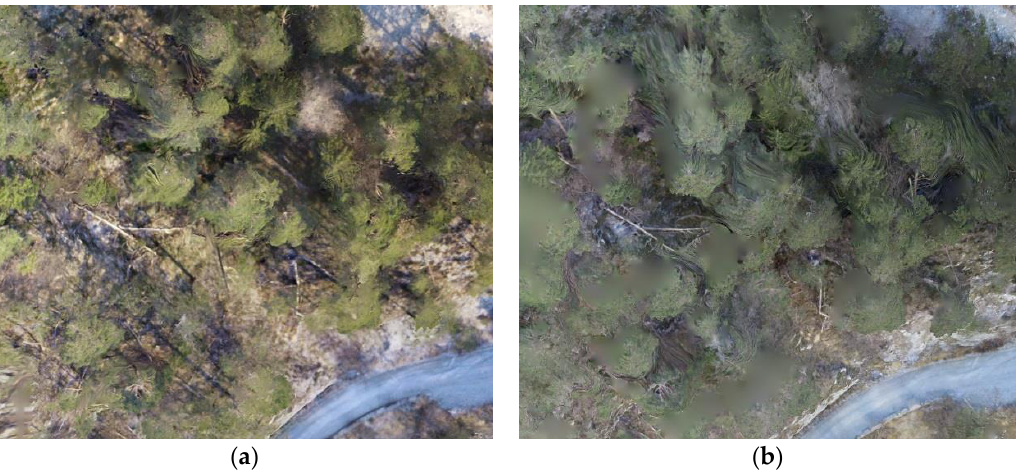
Figure 18. Inserts of orthophoto with 5-cm resolution: ( a ) from vertical images and ( b ) from oblique images.